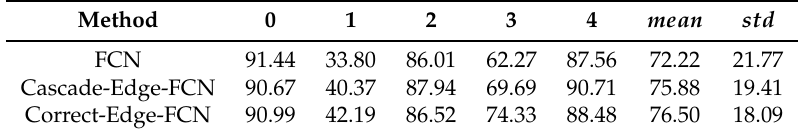
Table 4. Statistical validation on ESAR dataset. “0–4” represents the accuracy of the corresponding category. “Mean” and “std” reflect the statistical characteristics of category accuracy.